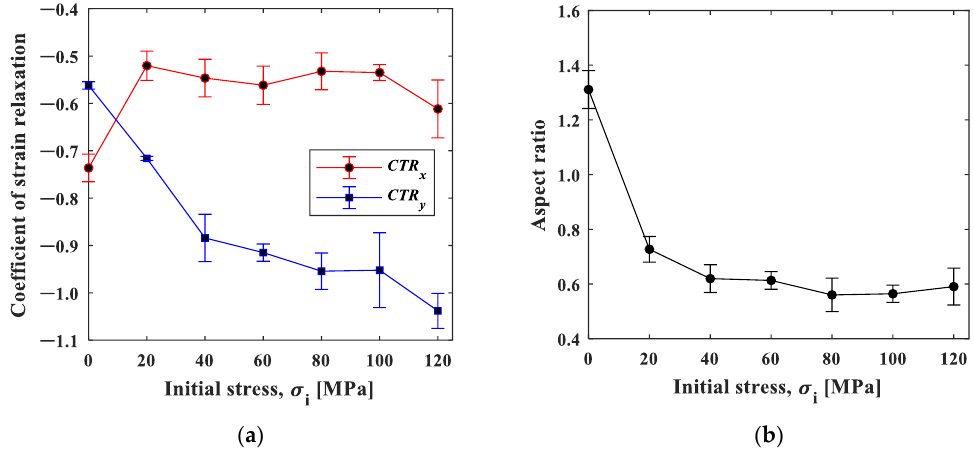
Figure 18. ( a ) 𝐶𝑆𝑅 – initial stress curve; and ( b ) aspect ratio. Figure 18. ( a ) CSR –initial stress curve; and ( b ) aspect ratio.